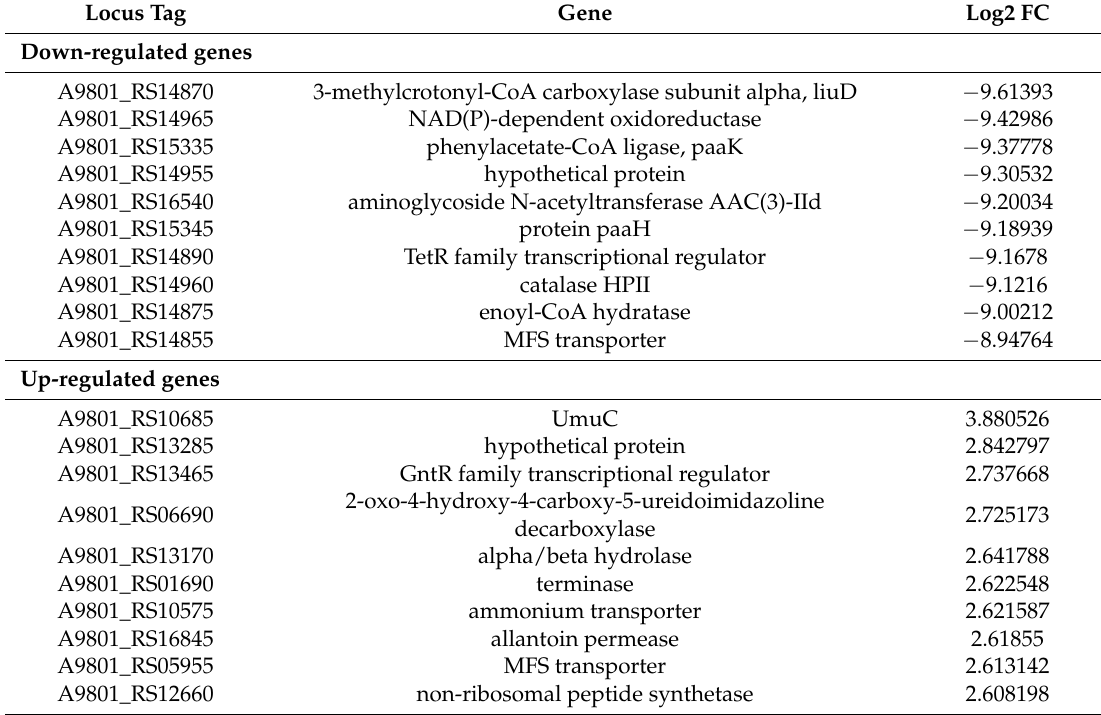
Table 3. Ten Highest Fold Changes of Downregulated and Upregulated Genes in QS-Deficient Mutant. Locus Tag Gene Log2 FC Down-regulated